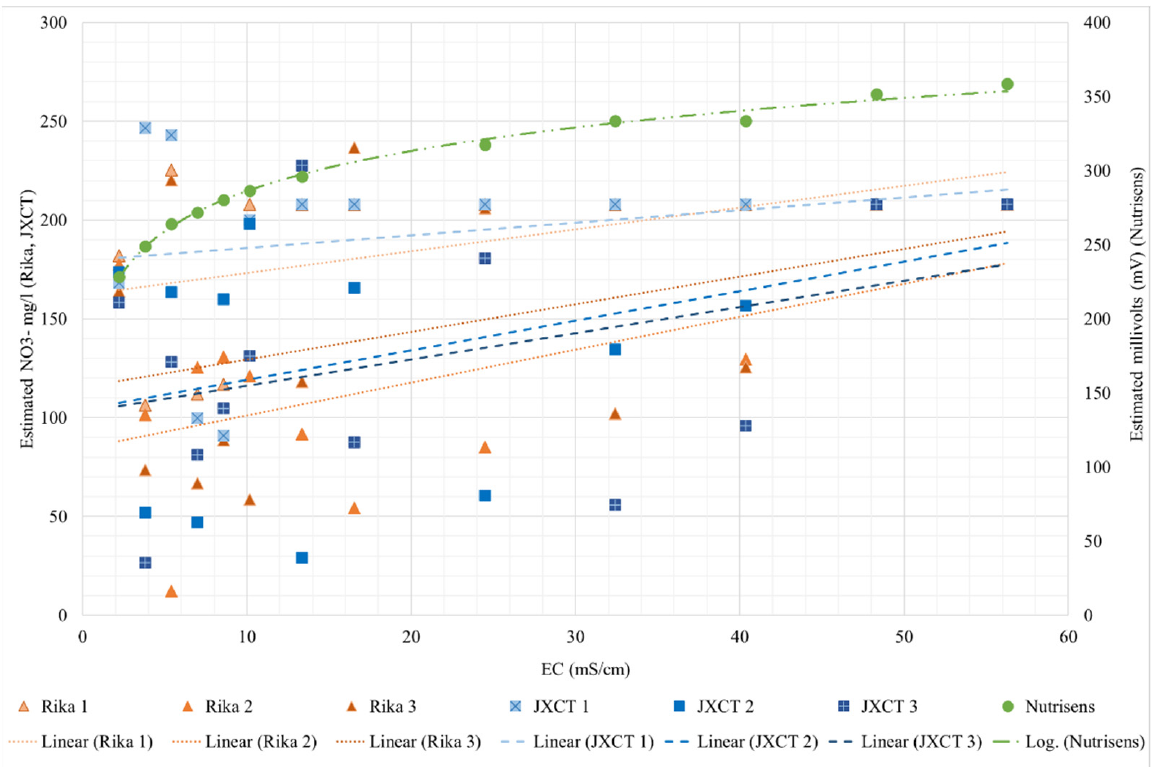
Figure 8. Behavior of the different probes (Nutrisens probe, RIKA and JXCT) when increasing the EC. On the x -axis the measured EC is shown; on the y -axis on the left the estimated NO 3 − mg/L for the Rika and JXCT probes is shown, whereas on the right the estimated millivolts for the Nutrisens probe can be